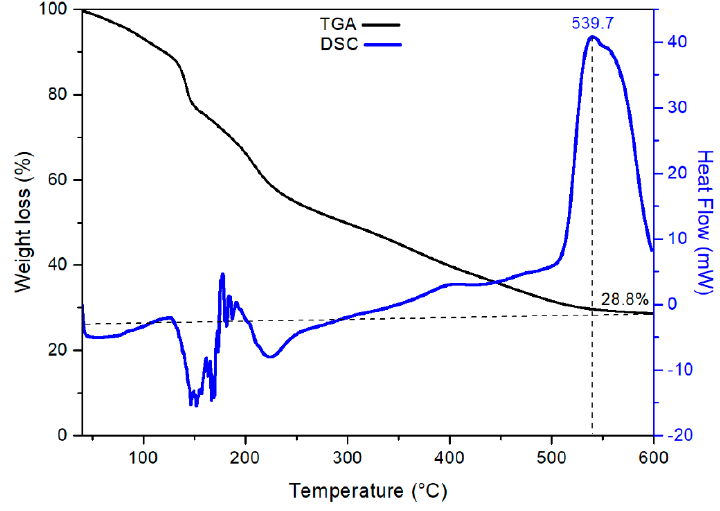
Figure 2. TG–DSC curves of dry gel (xerogel) powder precursor of CTO.